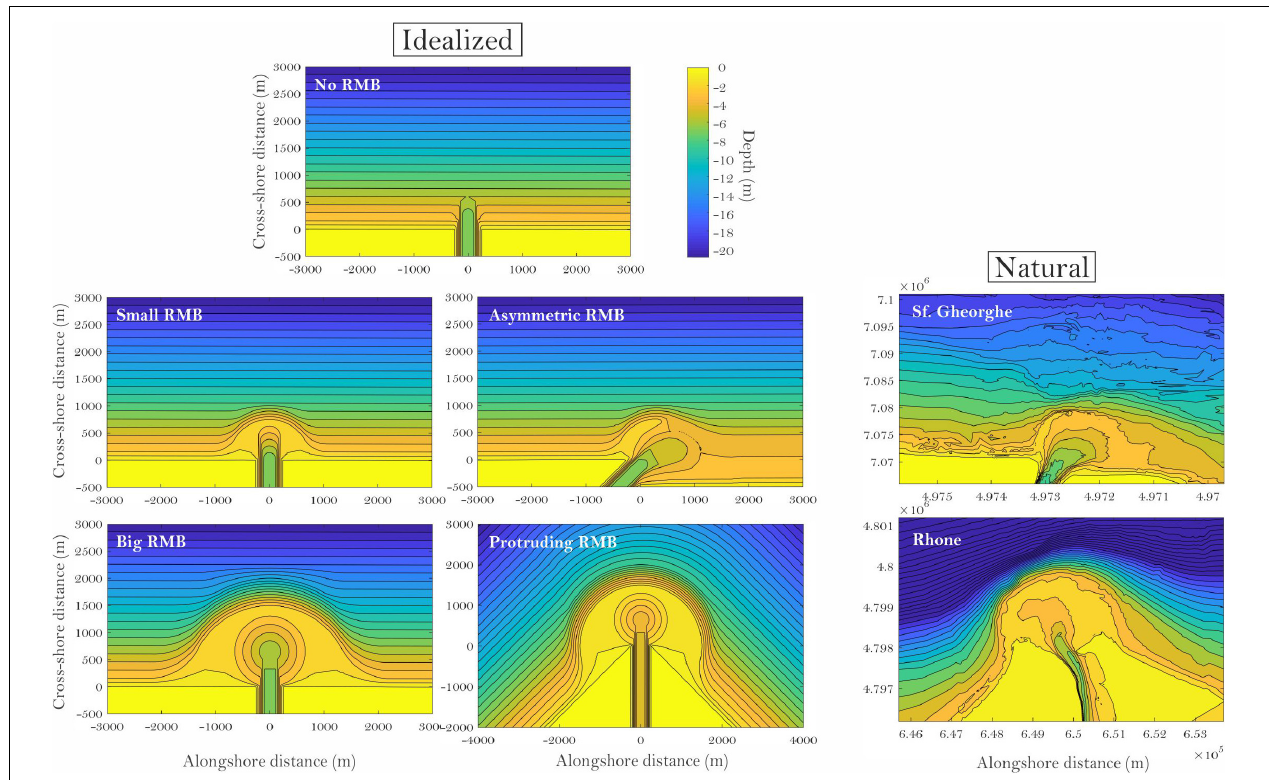
FIGURE 1 | The idealized river mouth bar (RMB) bathymetries used in the present study, and their natural counterparts (right).